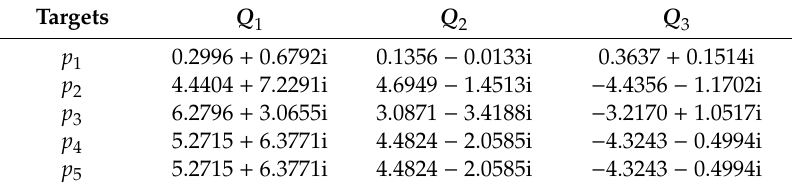
Table 2. The coordinates of the false point target. Table 3. Complex coe ffi cients of di ff erent false targets corresponding to three Table 3. Complex coefficients of different false targets corresponding to three transponders.